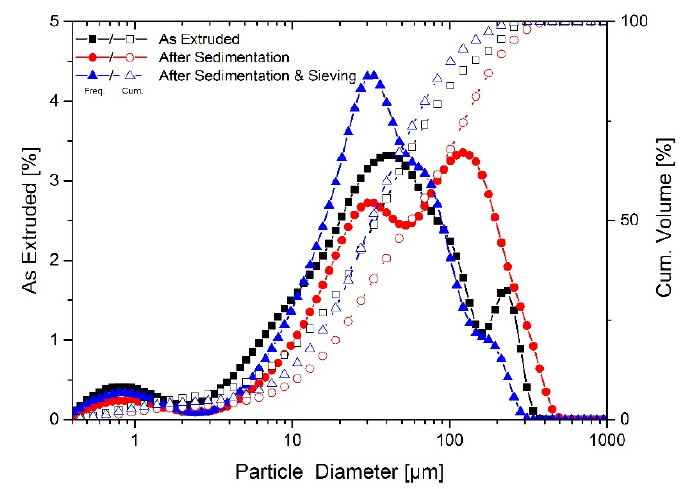
Figure 5. Volume-based particle size distributions for the PBT powder after different processing steps: after extrusion, sedimentation in the settling tank, and sedimentation & sieving with a 150 µm sieve. Solid curves and symbols represent the frequency distributions, open symbols with dashed lines represent the cumulative distributions. Table 3. Particle size distributions of the powder after different classification process steps.